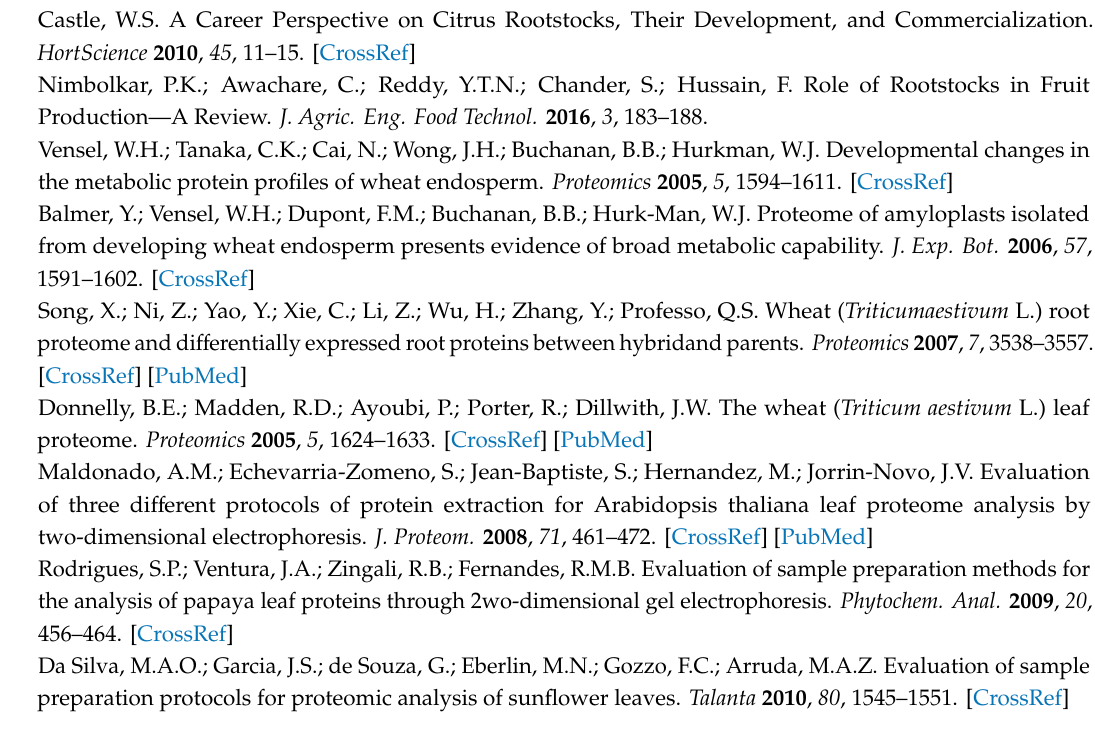
Figure S1: Linear MALDI spectra of the chromatographic fractions. Figure S2: SDS-PAGE of fraction 47 . Table S1. Predicted subcellular localization of the 78 identified proteins. Table S2: PROSITE output for the 20 proteins localized in the secretory pathway. Table S3: K numbers (KO) by BlastKOALA (https: // www.kegg.jp / blastkoala / ). Table S4: KEGG Mapper Search Result. Table S5. MS / MS identified peptides of